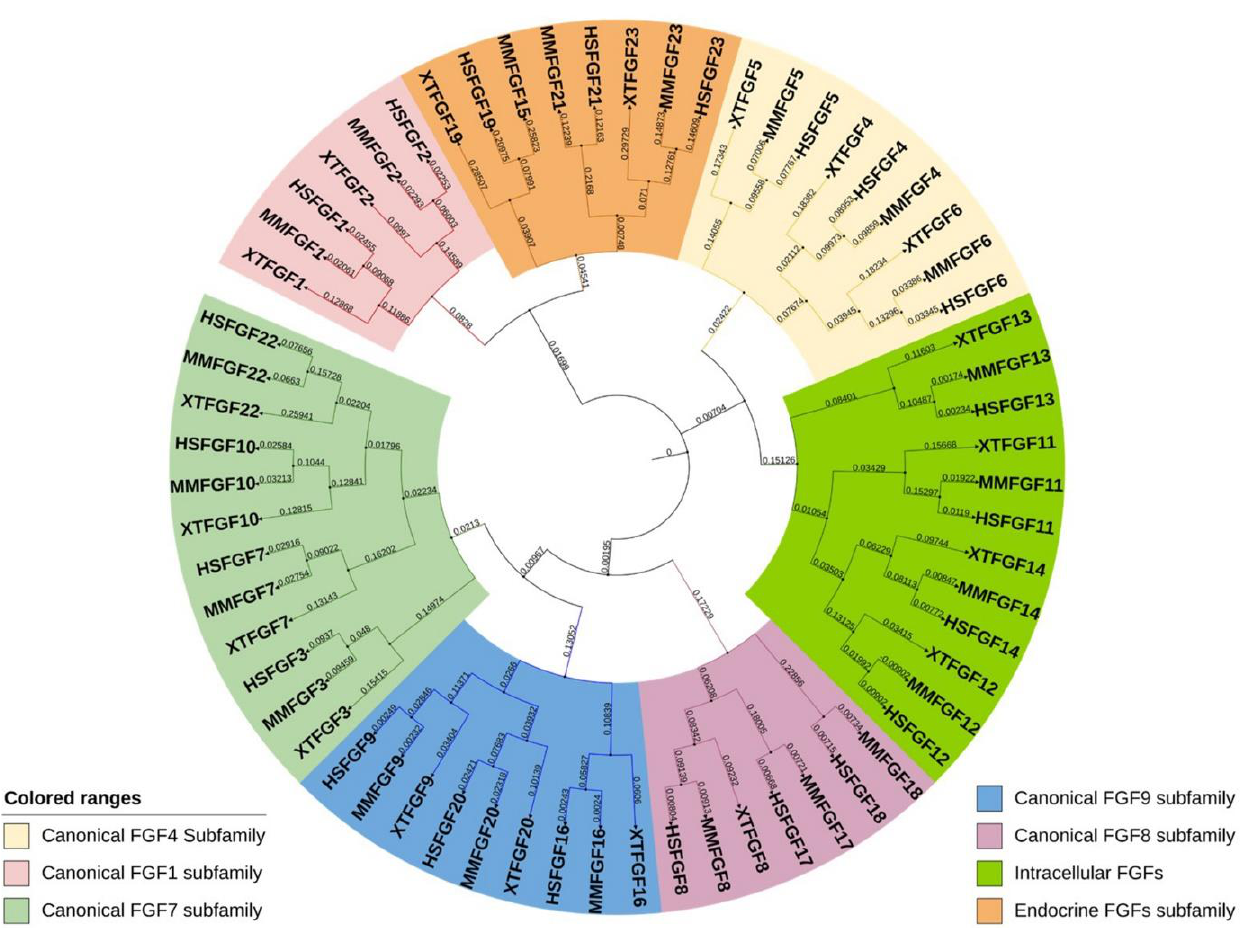
Figure 1. Evolutionary analysis of FGF proteins in humans, mice, and Xenopus. A circular rooted phylogenetic tree, depicting evolutionary relation between FGF proteins in Homo sapiens (HS), Mus musculus (MM), and Xenopus tropicalis (XT) was determined by using Clustal Omega and visualized by iTOL The evolutionary range among each protein is proportionate to the branch lengths and different subfamilies of FGF proteins are indicated by different color ranges. Table 1. Chromosomal location of FGF ligands in different vertebrate species . Information on the genome for human, mouse, and Xenopus models has been sourced from NCBI GeneBank, Mouse genome informatics, and Xenbase database, respectively.